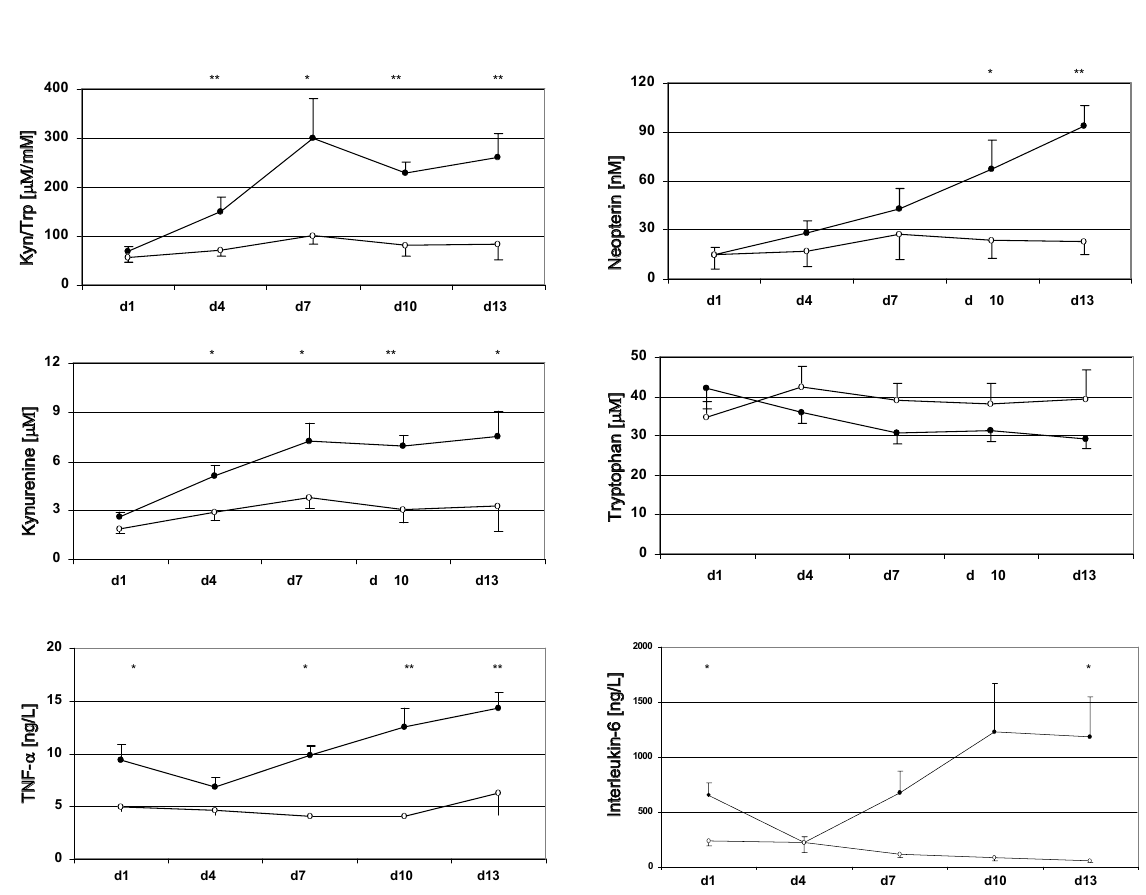
Figure 2. Serum kynurenine to tryptophan ratio (kyn/trp; upper left), and concentrations of neopterin (upper right), kynurenine (middle left), tryptophan (middle right), tumor necrosis factor- α (TNF- α ; lower left) and inter- leukin-6 (p = 0.001; lower right) patients with trauma and/or sepsis (11 survivors, open circles; 7 non-survivors, filled circles ) during follow-up for 2 weeks (mean S.E.M. is shown; ∗ p < 0.05, ∗∗ p <